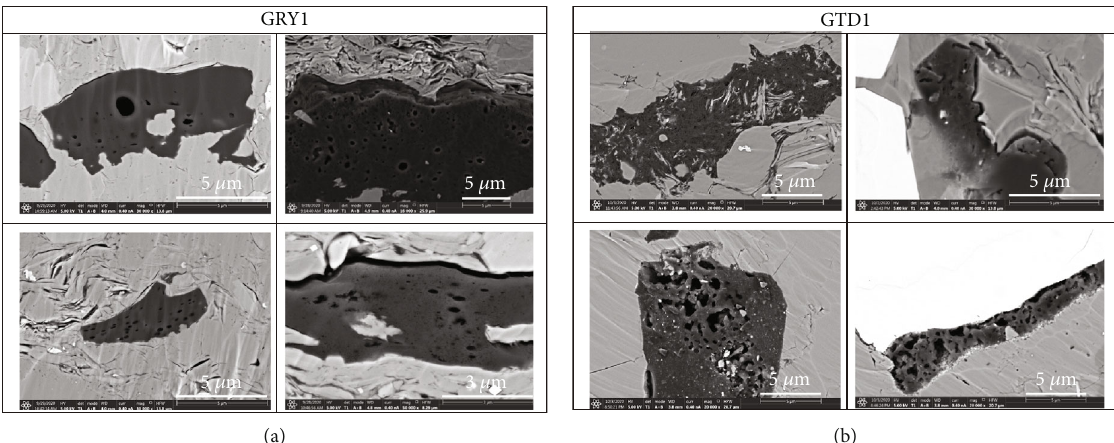
Figure 16: (a) Typical SEM photos of organic pores in Carboniferous shales (well GRY1); (b) typical SEM photos of organic pores in Devonian shales (well GTD1).